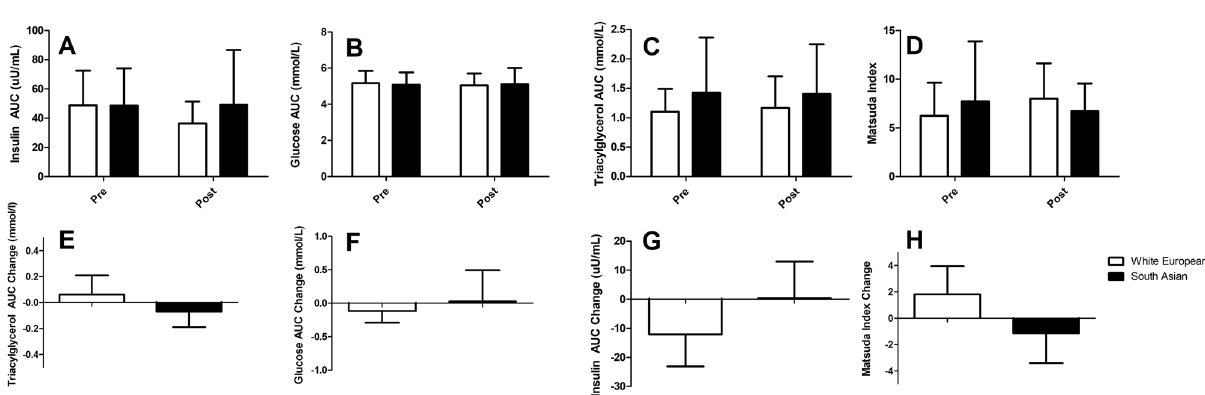
Figure 3. Muscle strength responses to 12 weeks of resistance exercise training in white Europeans and south Asians. Changes are adjusted for age and baseline values for that variable and are presented as mean (95% CI). *Denotes a significant difference between ethnicities in response to resistance exercise training (ANCOVA).